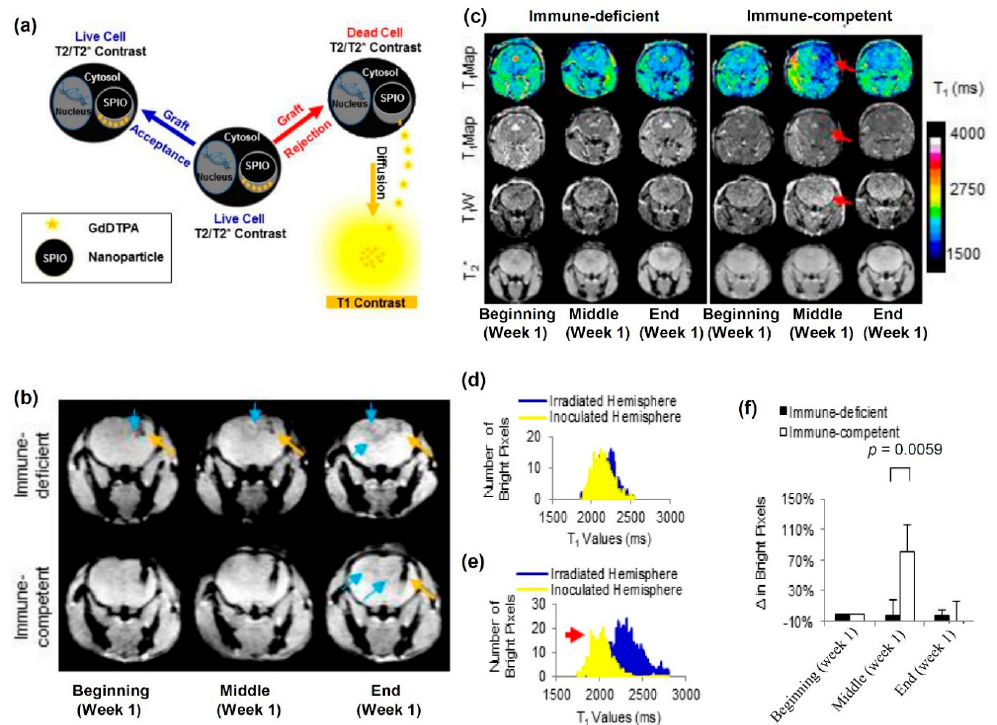
Figure 4. Cell tracking using the MRI dual contrast technique. ( a ) Schematic representing live cell-tracking by T 2 /T 2 * contrast enhancement, and cell death detection by T 1 contrast enhancement. Where SPIO stands for superparamagnetic iron oxide and GdDTPA stands for gadolinium-diethylenetriaminepentaacetic acid. ( b ) T 2 *-weighted images of immune-deficient and immune-competent mouse brains, indicating the site of cell delivery ( ↑ ) and cell migration to the radiation-induced lesion ( ↑ ). More cell migration to the injury site was detected in immune-deficient mice; ( c ) Comparison of T 1 contrast enhancement in immune-deficient and immune-competent mice, respectively, within the first week of cell transplantation. A significant T 1 contrast enhancement was observed in the slice adjacent to that of the cell delivery site in immune-competent mice. ( ↑ ) represents T 1 contrast enhancement in the slice adjacent to that of cell delivery; ( d ) Pixel intensity histograms of the ipsilateral and contralateral hemispheres of cell implantation before gra ſ t rejection indicate similar T 1 values in both hemispheres; ( e ) Pixel intensity histograms of the ipsilateral and contralateral hemispheres of cell implantation a ſ ter gra ſ t rejection indicate lower T 1 values in the hemispheres ipsilateral to cell implantation. ( ↑ ) represents T 1 contrast enhancement in the slice adjacent to that of cell delivery; ( f ) Quantification of T 1 contrast enhancement in immune-deficient and immune-competent mice, respectively, at the beginning, middle, and end of week one. The signals were normalized for each mouse and indicate significant T 1 contrast enhancement within week one in immune-competent mice, indicating cell death. The images and caption are reprinted from Ngen et al. [88].